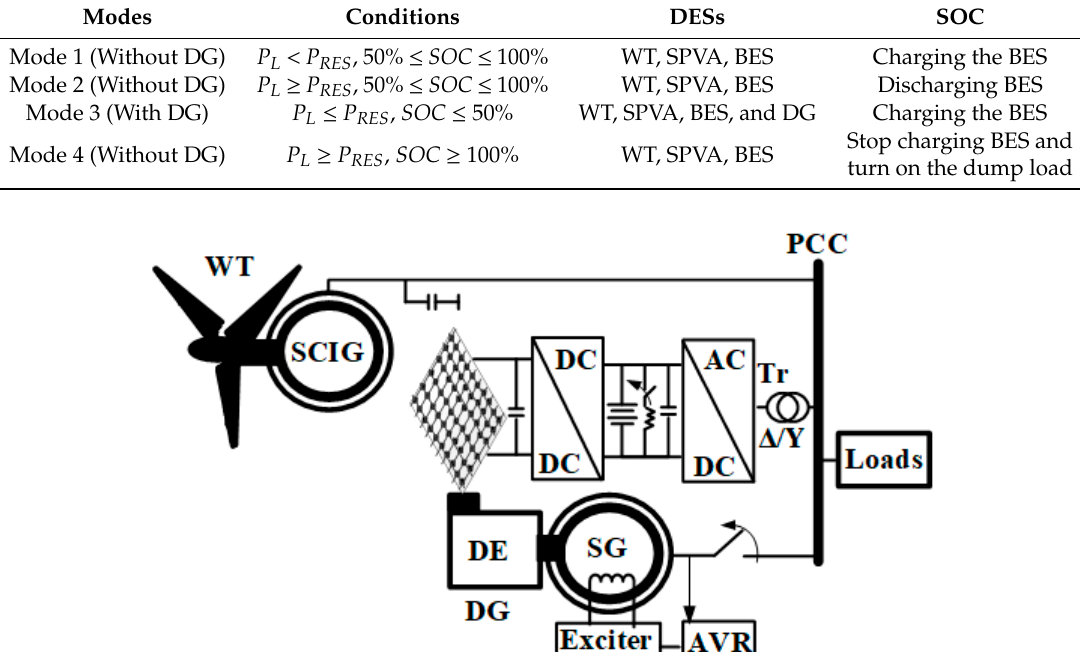
ff -grid configuration based on SPVA, WT, and Figure 12. Off-grid configuration based on SPVA, WT, and DG. Figure 12. O